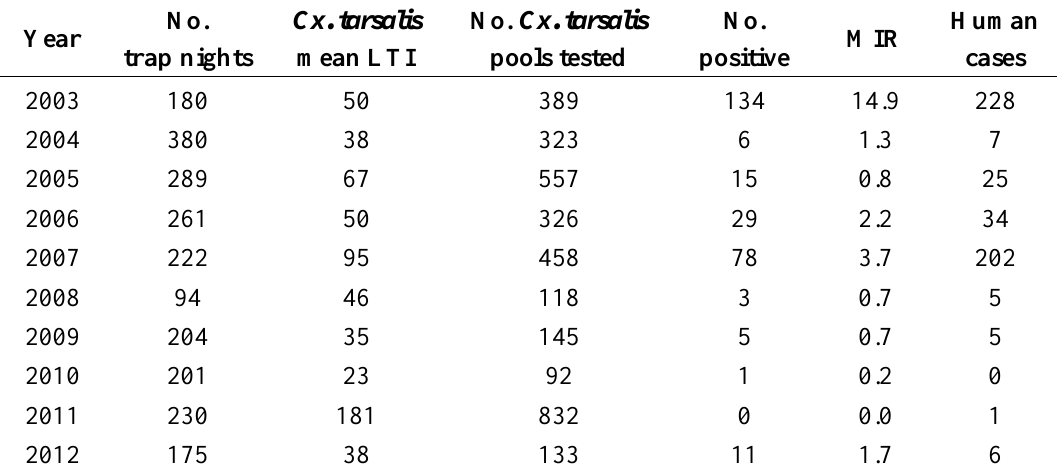
Table 1. Mosquito collection results aggregated across all sites for each year. The mean light trap index provides a measure of Cx. tarsalis abundance across years standardized by trapping effort. The minimum infection rate provides an estimate of the number of infected females per 1000 mosquitoes. Our data (2009–2010) is compared with data from previous years provided by Johnson et al . ([16], unpublished). Human data were obtained from ArboNET. LTI = light trap index = number of sorted Cx. tarsalis divided by the number of traps; and MIR = minimum infection rate = number of positive samples divided by the number of Cx. tarsalis tested multiplied by